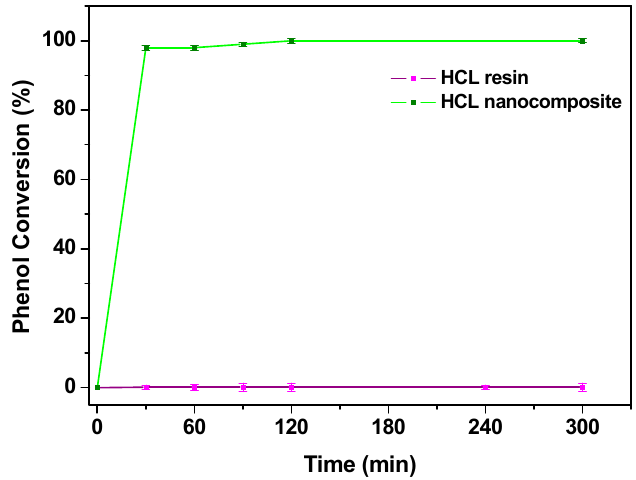
Figure 11. Results of CWAO phenol oxidation with HCL resin and HCL nanocomposite. Reaction condition: temperature, 95 °C; pressure, 0.3 MPa; air gas flow, 4.6 NL/h; concentration of solid, C Solid = 0.4 g/L; phenol concentration, 1000 mg/L. Before starting the tests, catalyst loaded and unloaded resins were saturated with phenol in the absence of the airflow at 95 °C (i.e., 1000 mg/L was the starting phenol concentration for the tests collected in this graph).